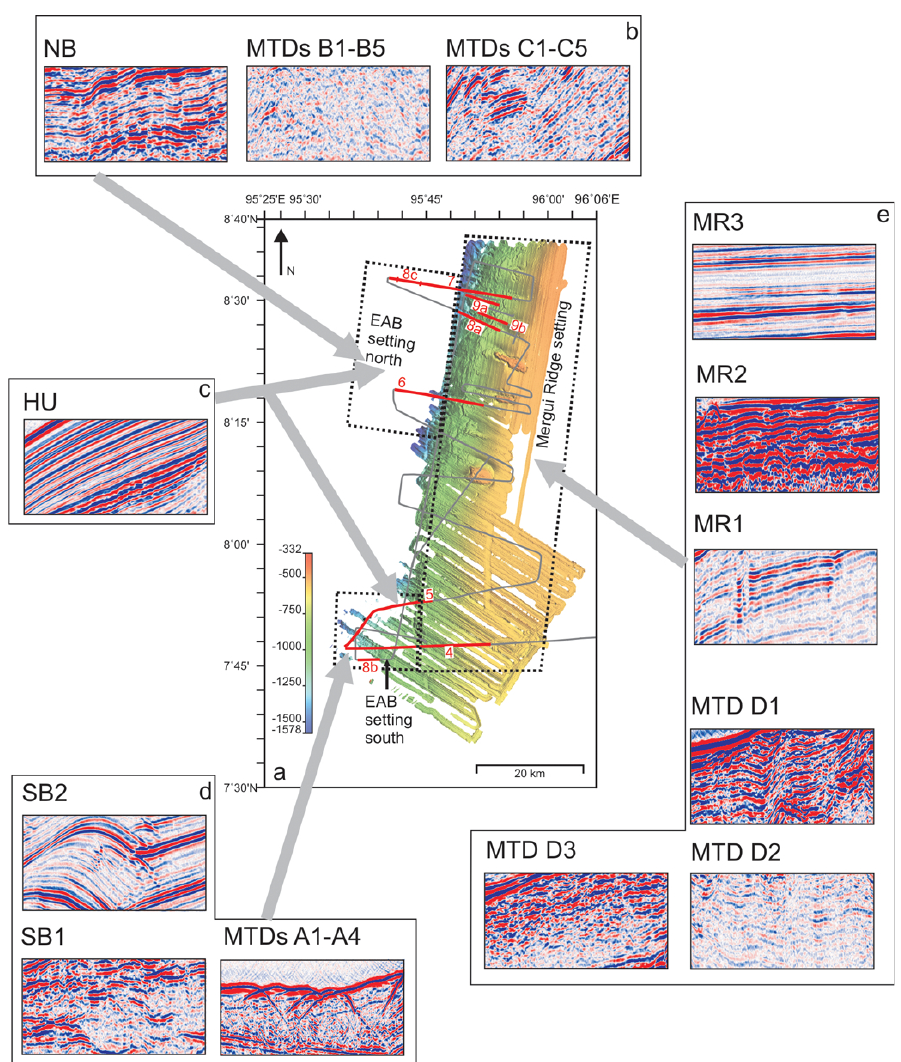
Fig. 2. (a) Bathymetric map of the working area modified after Jintasaeranee et al. (2012). The stippled black lines mark the three defined settings in the working area: Mergui Ridge, East Andaman Basin north and East Andaman Basin south. (b) Examples of the acoustic facies that were identified in the subsurface sediments of the northern working area, which are background sedimentary unit NB and MTDs B1–B5 and C1–C5. (c) Example of the acoustic facies of the surficial sedimentary unit HU identified throughout the East Andaman Basin area. (d) Examples of acoustic facies identified in the subsurface sediments of the southern working area, which are background sedimentary units SB1 and SB2 and MTDs A1–A4. (e) Examples of the acoustic facies identified in the Mergui Ridge setting, which are subsurface sedimentary units MR1 and MR2, surficial unit MR3 and MTDs